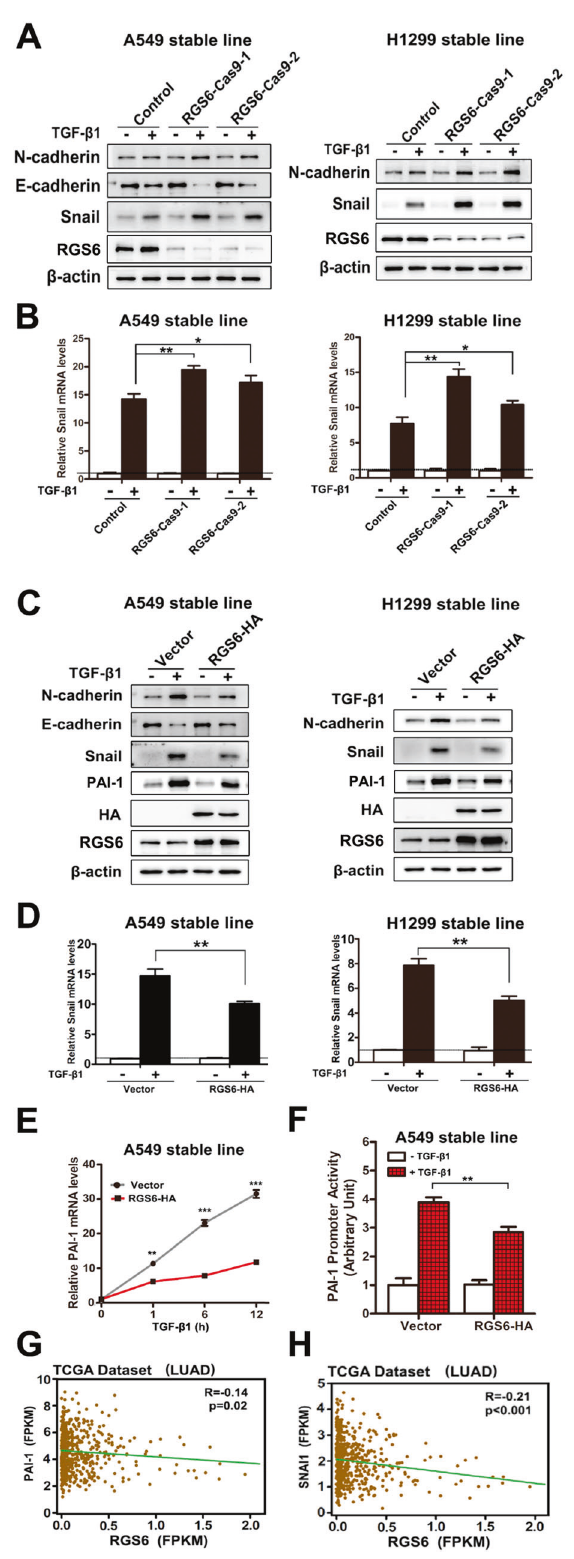
(Fig. 5J). Consistent with the earlier time course study (Fig. 5I), the rate of SMAD3 dephosphorylation in RGS6-HA cells was slower than that in control cells (Fig. 5J). This result not only con fi rms that retaining of p-SMAD3 in the cytoplasm in RGS6-HA cells protects